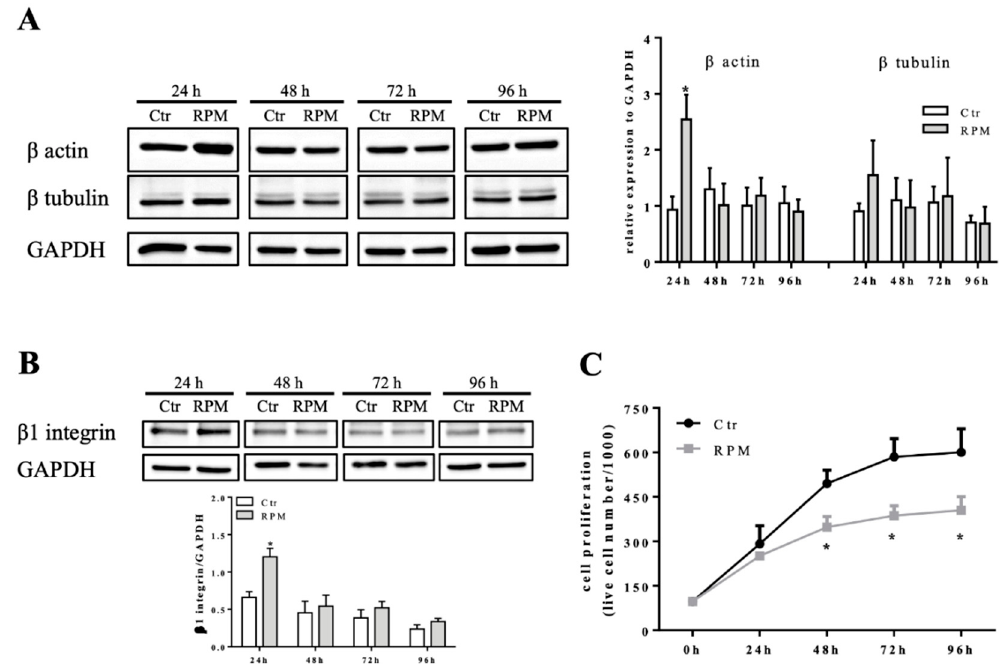
Figure 2. Modulation of cell mechanosensors and proliferation. ( A , B ) Representative immunoblots of β actin, β tubulin, and β 1 integrin expression levels in extracts from control cells at 1g (Ctr) or cells exposed to s-microgravity (RPM) at different exposure times (24–96 h). The densitometric analyses are plotted as the relative expression calculated as a ratio between the optical density (OD) × mm 2 of each band and OD × mm 2 of the corresponding GAPDH band, used as loading control. ( C ) Cell proliferation tested on Ctr and RPM-exposed cells at different exposure times (24–96 h). The data are presented as the means ± SEM from three independent experiments. * p < 0.05 vs. Ctr.